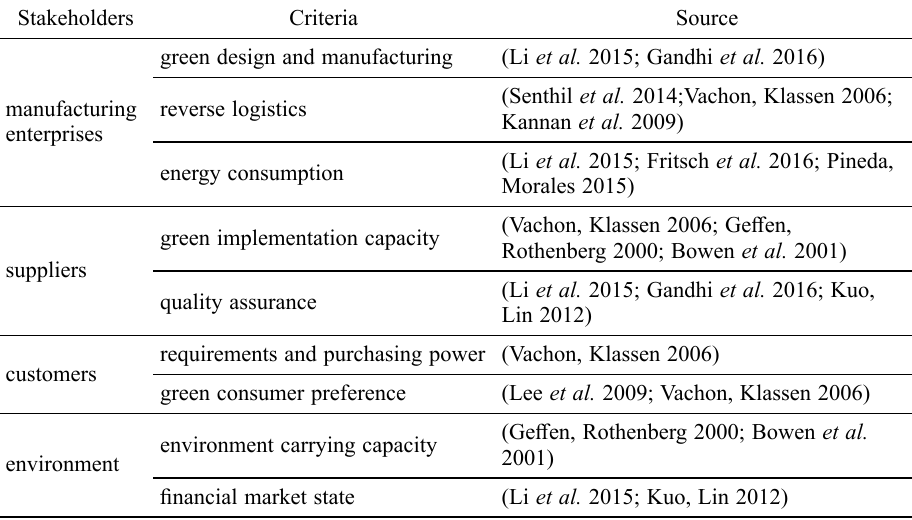
Table 1. Detailed criteria of GCI project